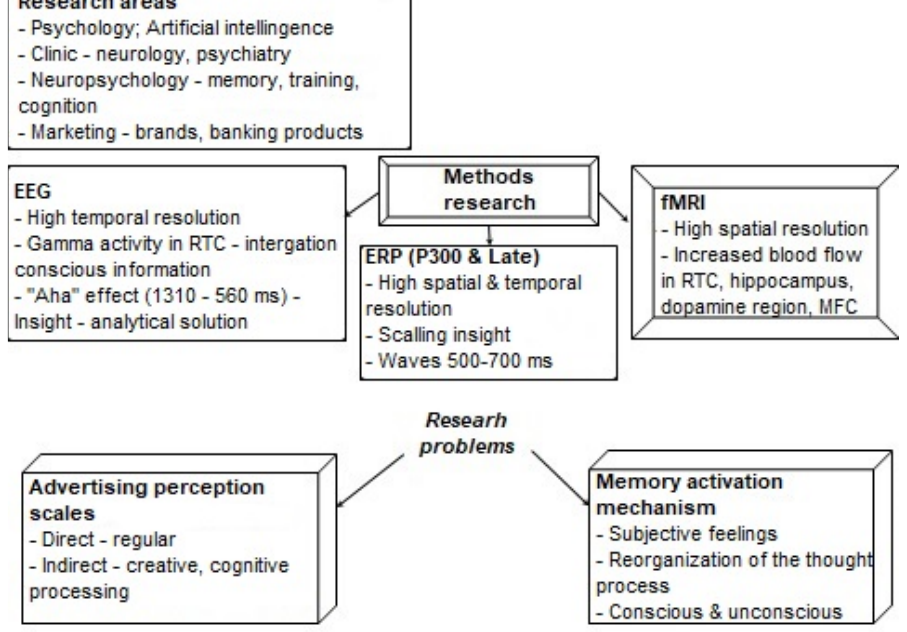
Figure 5. The general directions, methods, and problems of insight